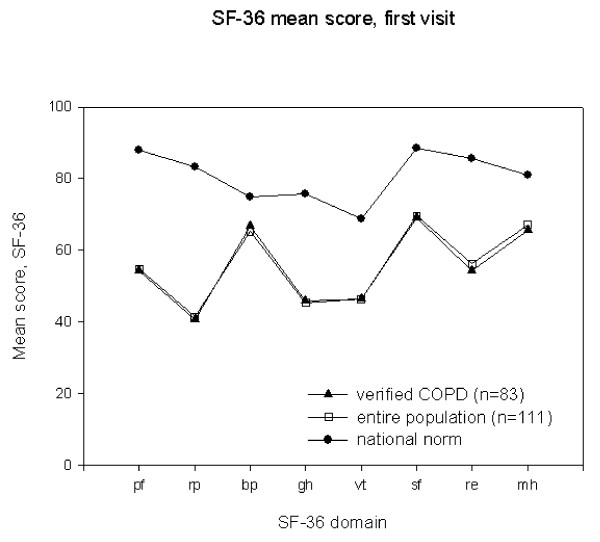
Baseline SF-36 domain scores for the entire study sample, (n = 111, unfilled squares), COPD verified by spirometry (n = 83, filled triangles). National norm data (filled circles) for reference. pf = physical functioning, rp = role-physical, bp = bodily pain, gh = general health, vt = vitality, sf = social functioning, re = role-emotional, mh = mental health.